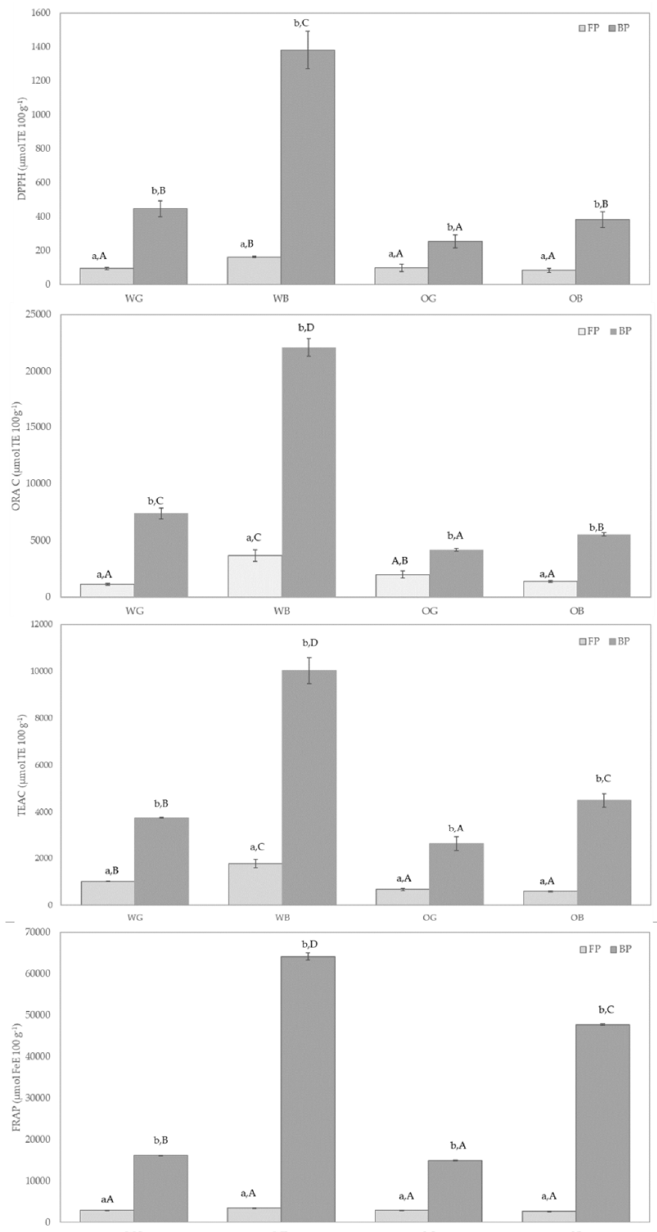
Figure 4. DPPH, ORAC, ABTS, and FRAP values for free phenolic fraction (FP) and insoluble phenolic fraction (BP) of wheat grain (WG), oat grain (OG), and their bran, wheat bran (WB) and oat bran (OB). Results were expressed in µ mol TE 100 g − 1 for ORAC, DPPH, ABTS, and µ mol Fe E 100 g − 1 for FRAP of dry sample. Different lowercase letters indicate significant differences ( p < 0.05) in a given sample (WG, WB, OG, or OB) between fractions (FP vs. BP) and capital letters indicate significant differences ( p < 0.05) in a given fraction (FP or BP) among samples (WG, WB, OG, and OB).